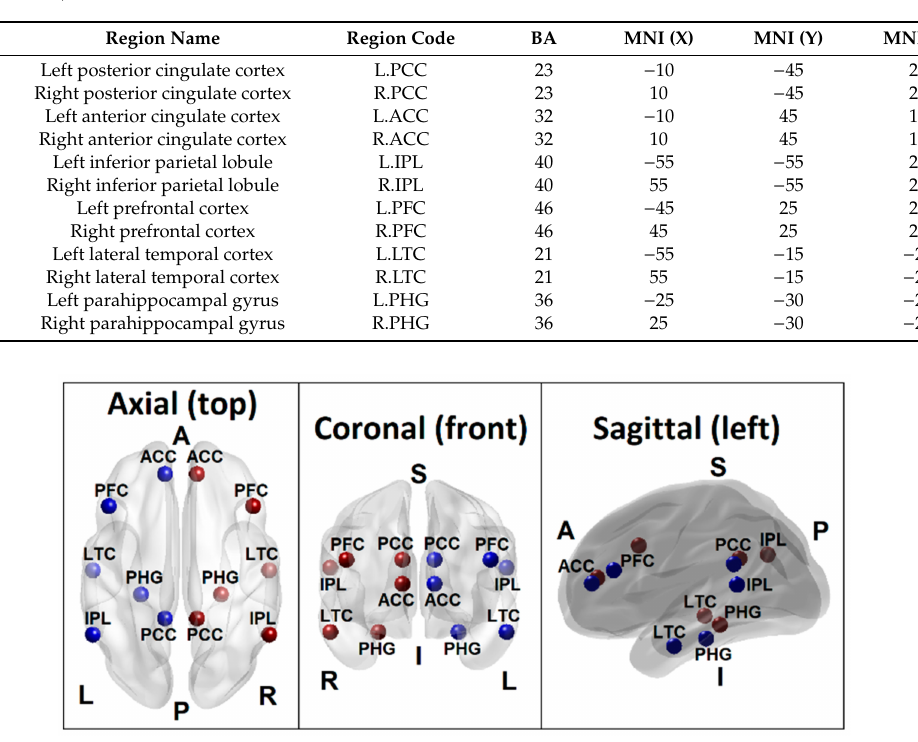
Table 2. Default Mode Network (DMN) seed regions and the Montreal Neurological Institute (MNI) coordinates, as referenced from the exact Low Resolution Electromagnetic Tomography (eLORETA) software.